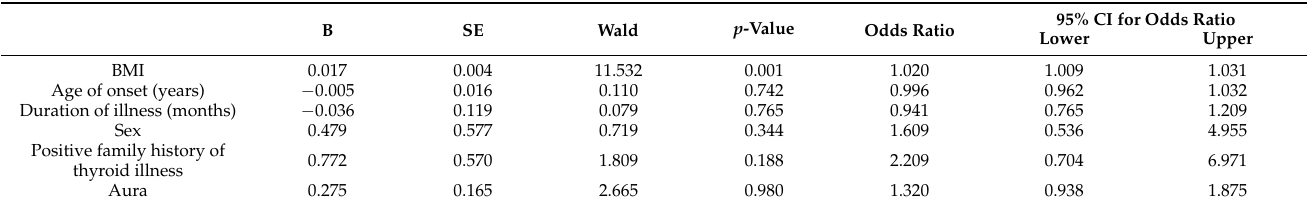
Table 5. Logistic regression analysis for variables associated with ScH in migraineur children.